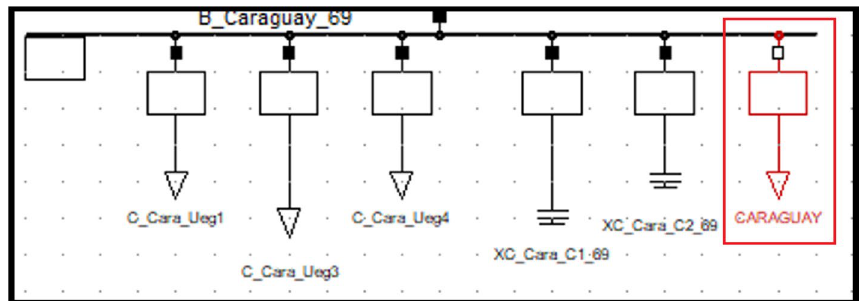
Figure 6. Caraguay static (general) load model representation.